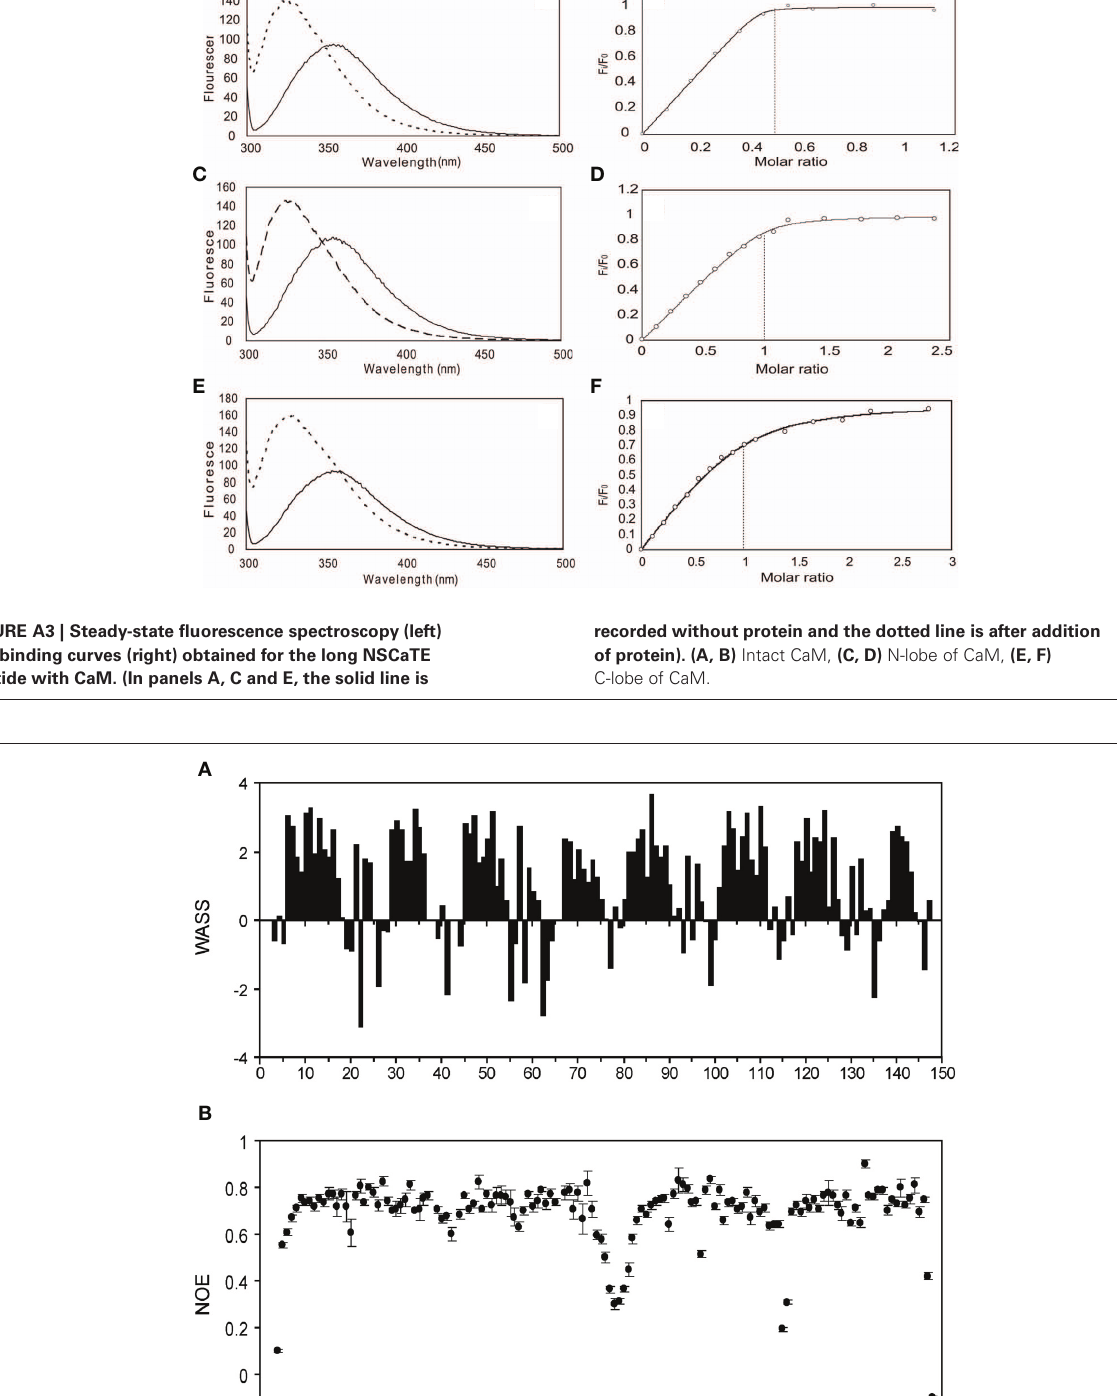
FIGURE A4 | (A) Weighted average secondary shifts (WASS) for the short NSCaTE bound state of intact Ca 2 + /CaM. A total of 2.5 equivalents of unlabeled peptide was added to saturate the protein. (B) { 1 H } - 15 N NOE data for the short NSCaTE bound state of Ca 2 +